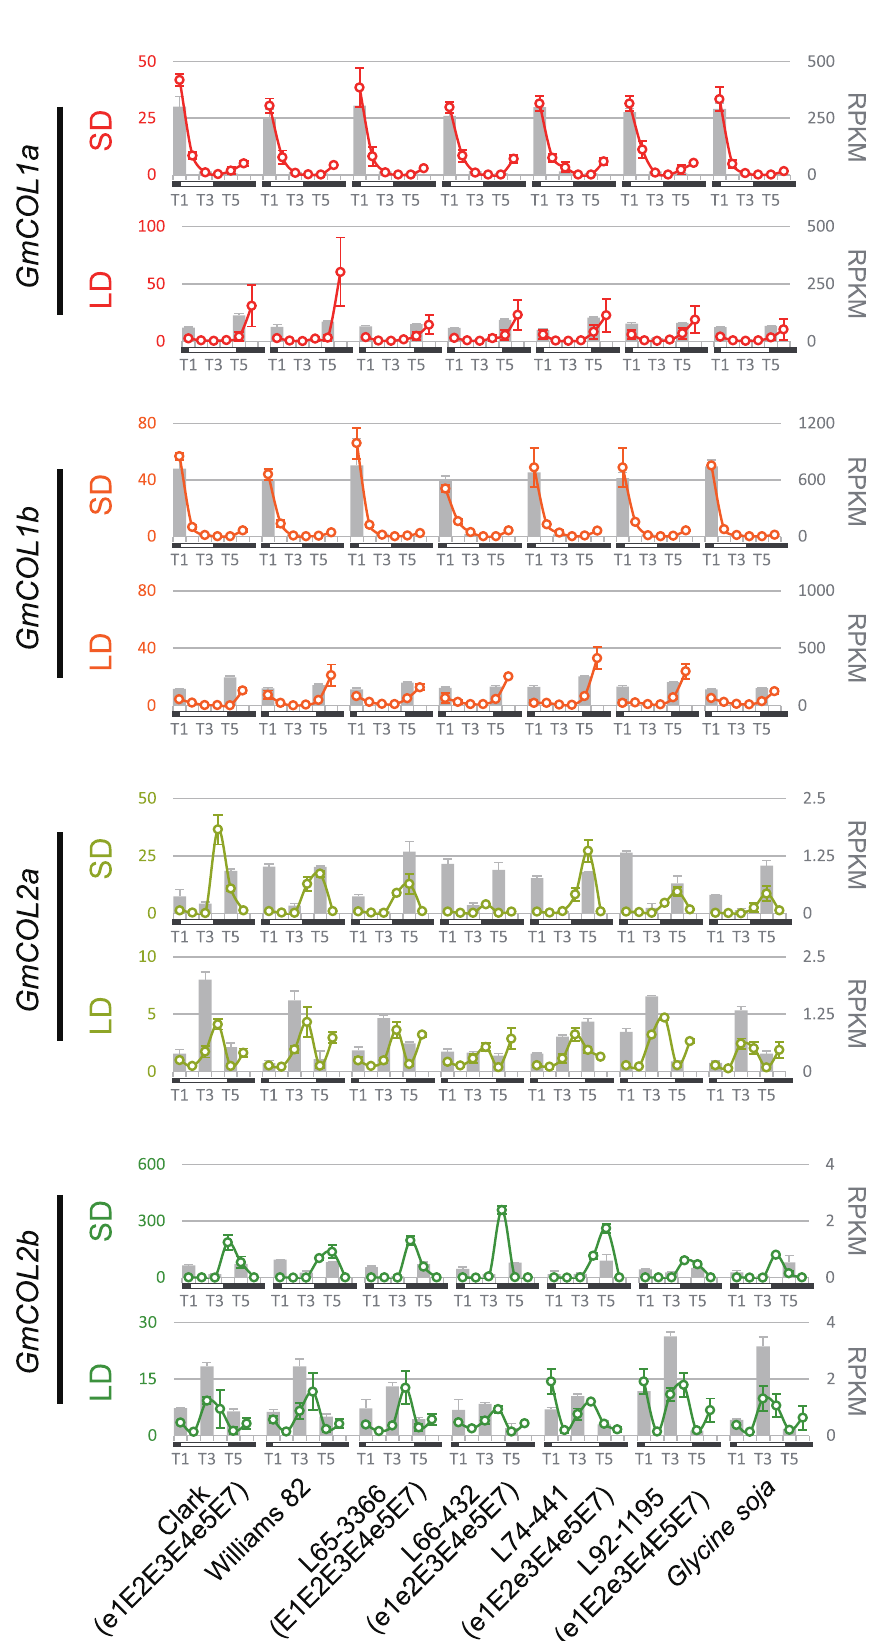
Figure 4. mRNA abundance of GmCOL1a,GmCOL1b,GmCOL2a and GmCOL2b . Circles and solid lines represent the data obtained by qRT-PCR, and gray bars represent the data obtained by RNA sequencing. Relative expression levels of qRT-PCR among the samples in each panel are shown on